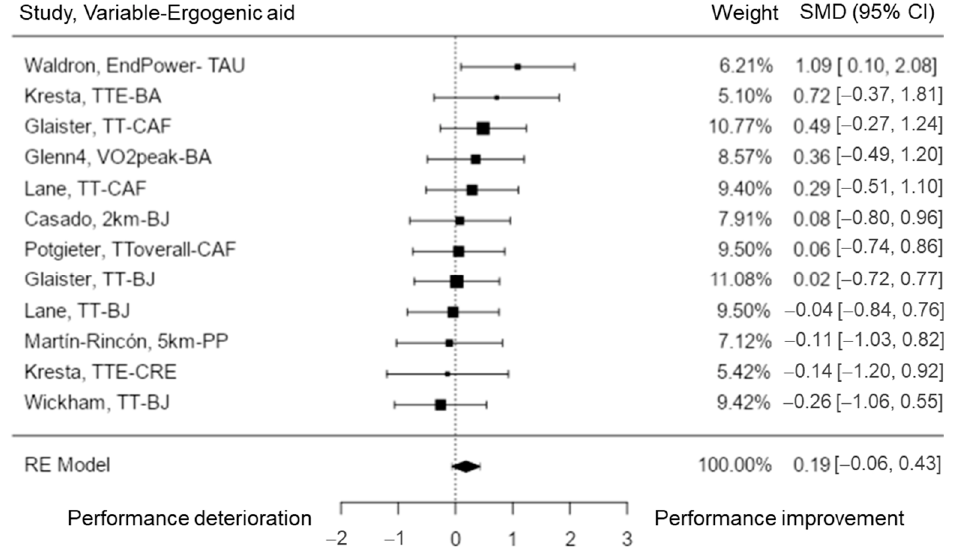
Figure 6. Aerobic performance forest plot . TTE = time to exhaustion; TT = time trial.